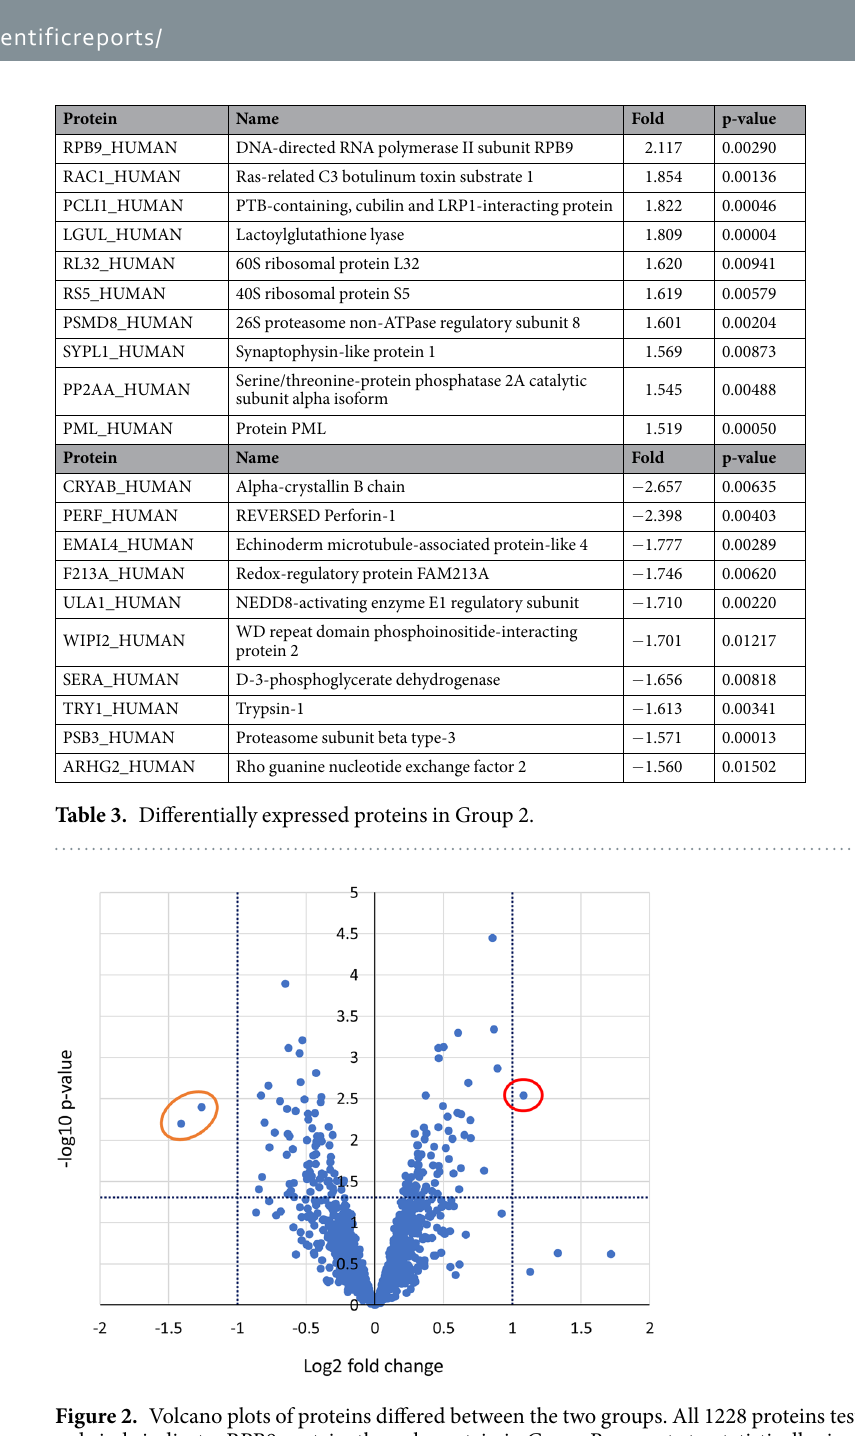
Figure 2. Volcano plots of proteins differed between the two groups. All 1228 proteins tested are plotted. The red circle indicates RPB9 protein, the only protein in Group B present at a statistically significantly higher amount. The orange circle indicates perforin-1 and the alpha-crystallin B chain, the expressions of which were